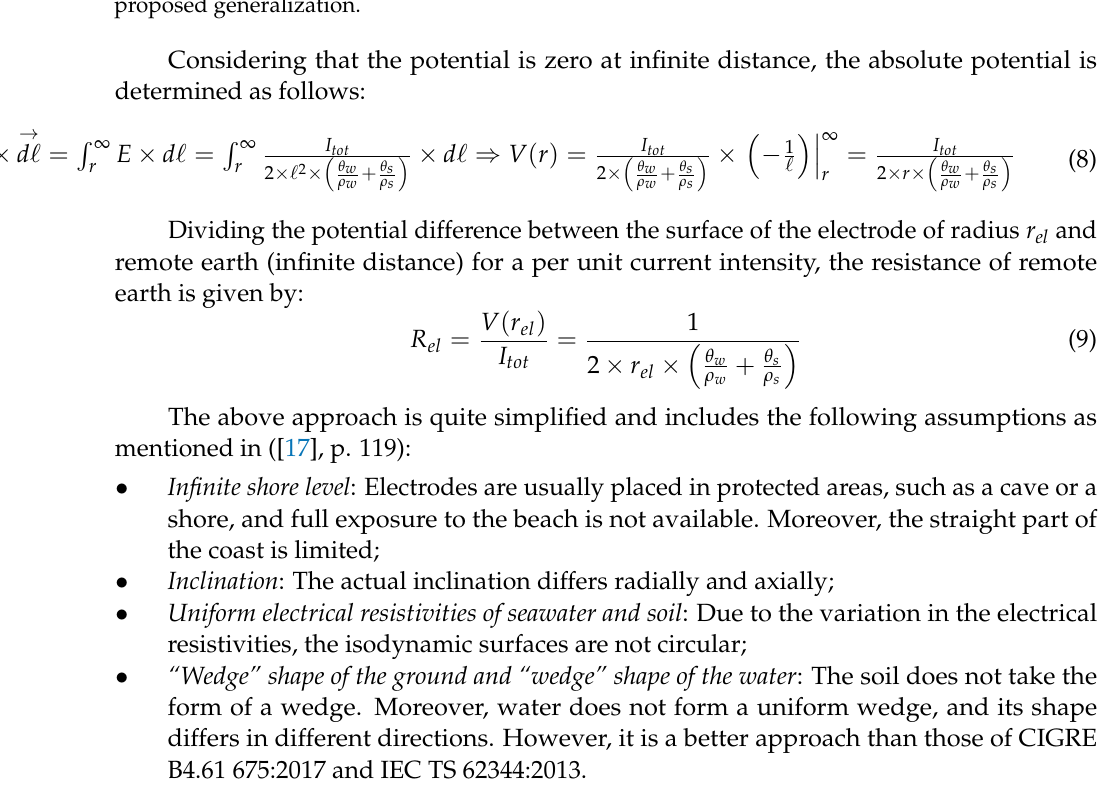
Figure 4. Simplified model for electrode placement on shore or in near-shore sea based on ( a ) Figure 5.35 by CIGRE B4.61 675:2017 [17], ( b ) Figure 5 by IEC TS 62344:2013 [34], ( c ) the proposed